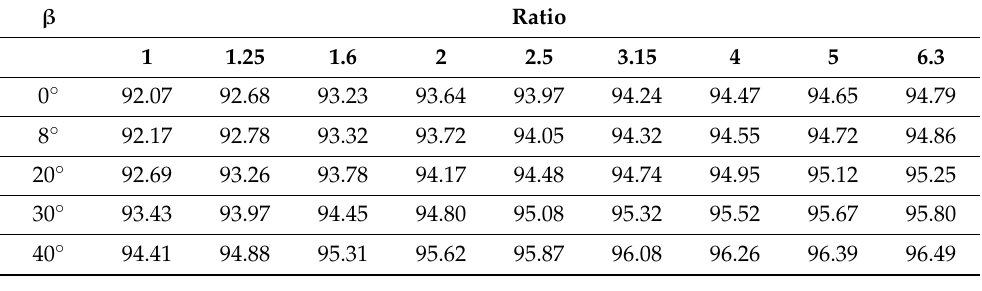
Figure 4. Gear efficiency versus gear ratio for lubricated gears. Table 6. Lookup table for gear ratio and efficiency (without lubrication).